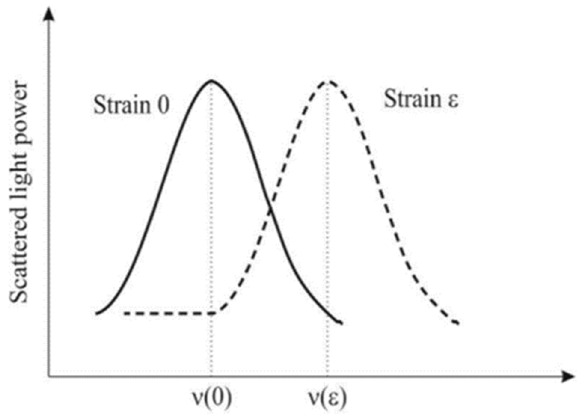
Figure 9. Brillouin Frequency shift [21].